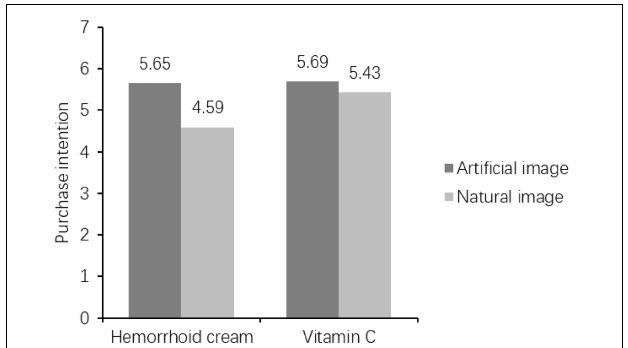
FIGURE 1 | The purchase intentions of different